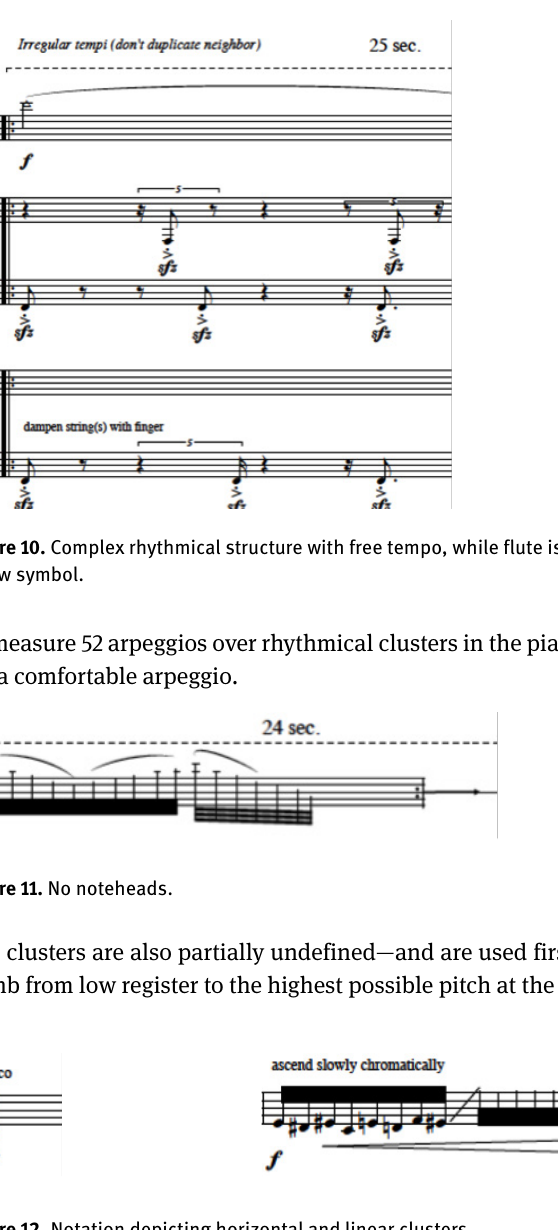
Figure 12. Notation depicting horizontal and linear clusters.